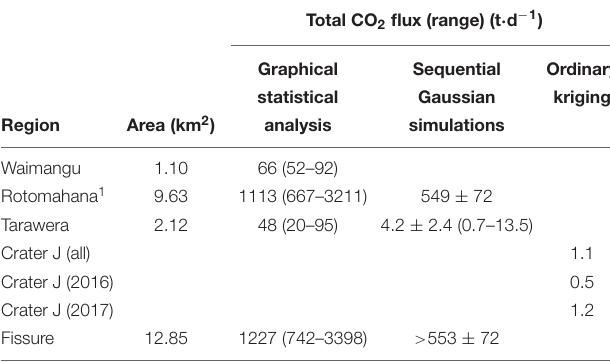
TABLE 2 | Total CO 2 flux using graphical statistical analysis, sequential Gaussian simulations, and ordinary